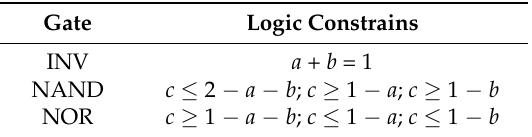
Table 2. ILP compatible logic constrains for basic gates